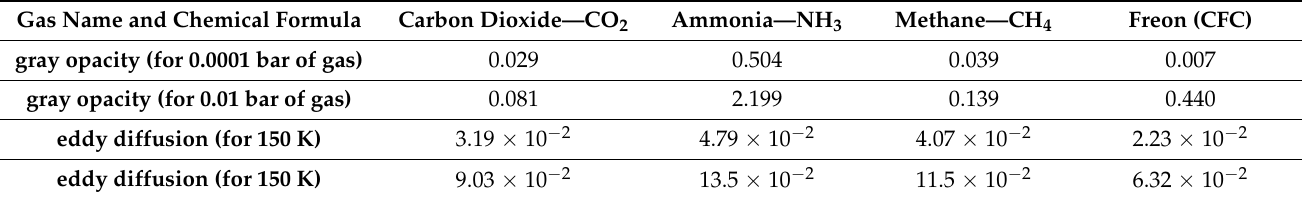
Table 1. Parameters for greenhouse gasses